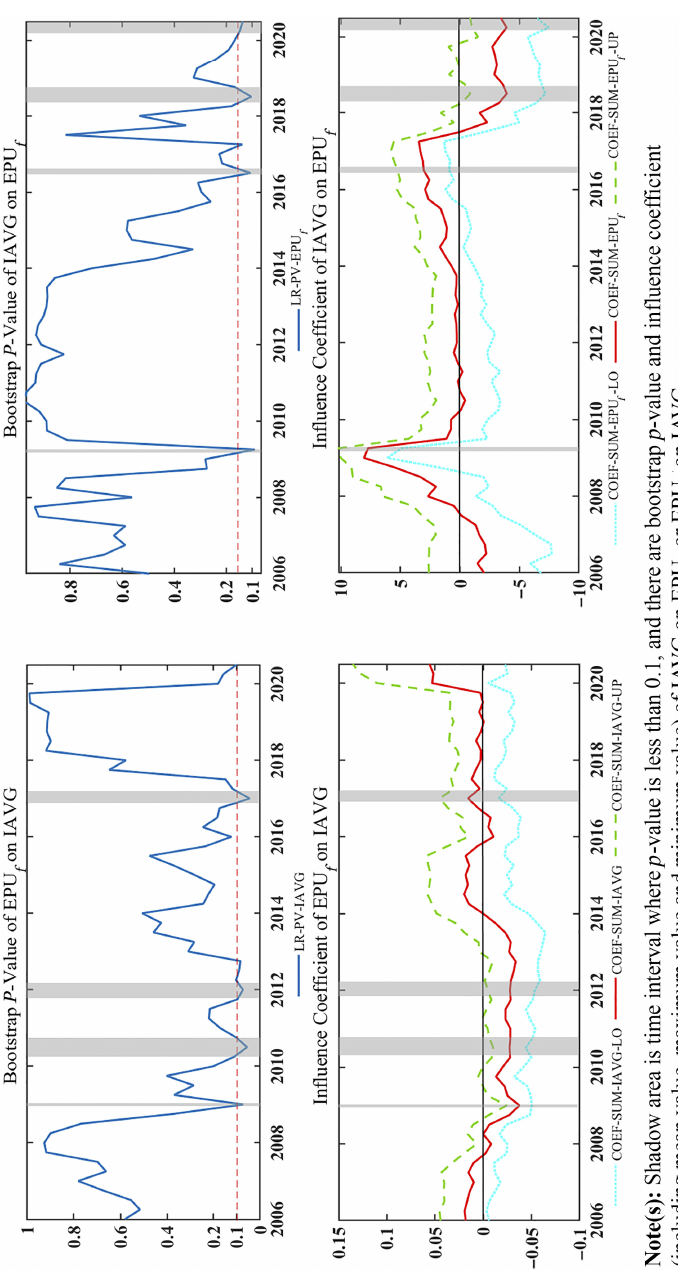
Figure 3. Sub-sample bootstrap and